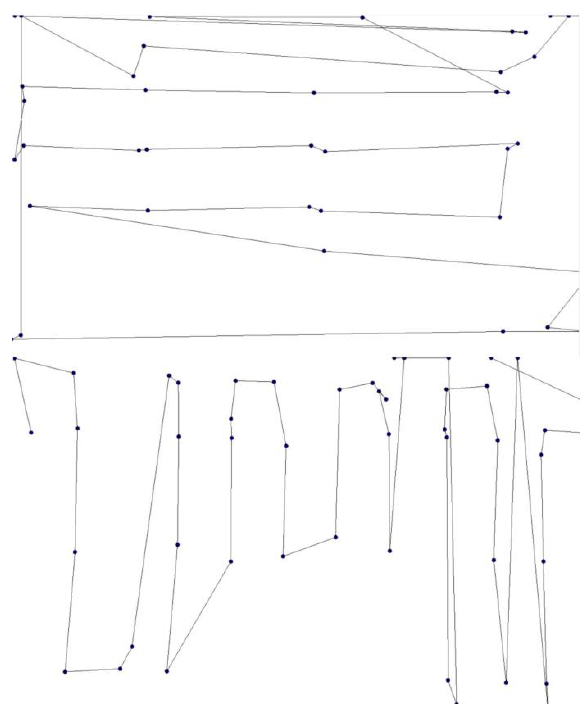
Figure 4: Recorded scanpaths during a non-optimal set-up. First image: poor recordings on the horizontal stimulus; second image: poor recordings on the vertical stimulus. Both lack fixation on multiple target points.